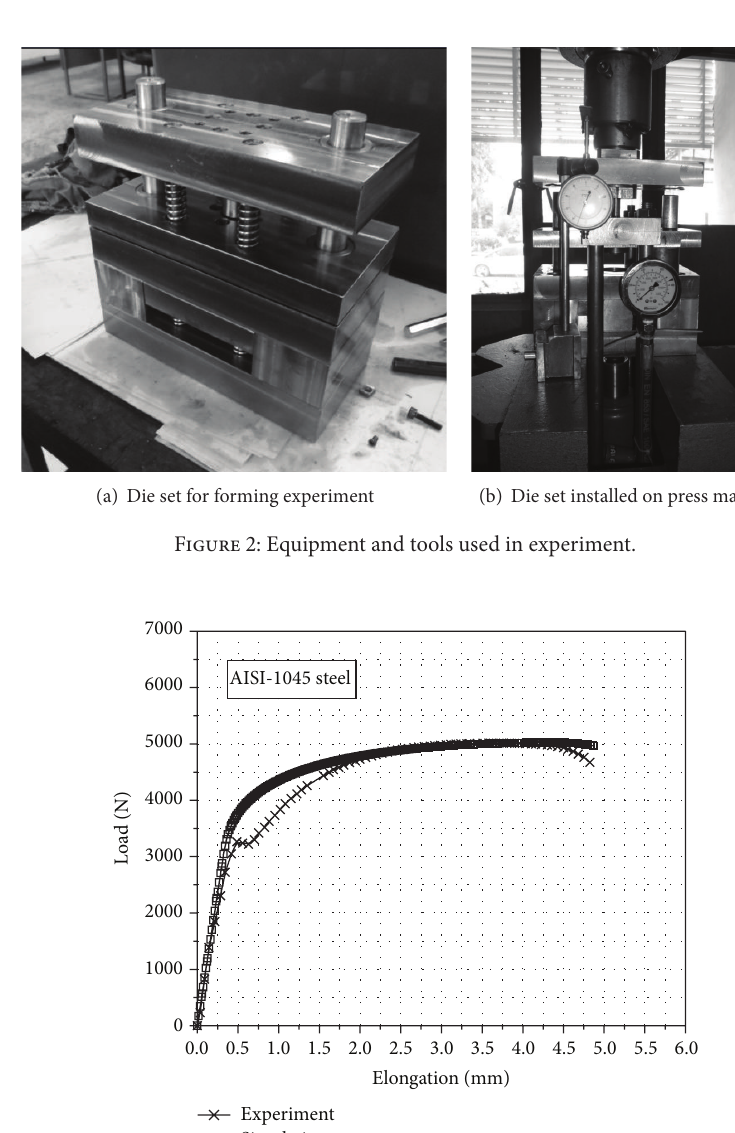
Figure 1: Configuration of sheet metal extrusion modeling.